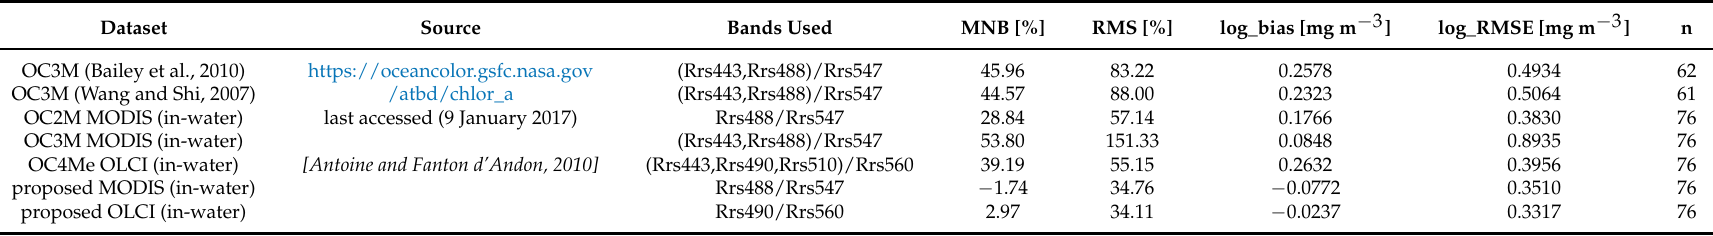
Table 4. Error comparison of chlorophyll a concentration retrieved from satellite Chla maps corrected using two atmospheric correction methods [61,62]); predictions based on standard OC algorithms applied to in-water measurements and the new algorithm proposed here.